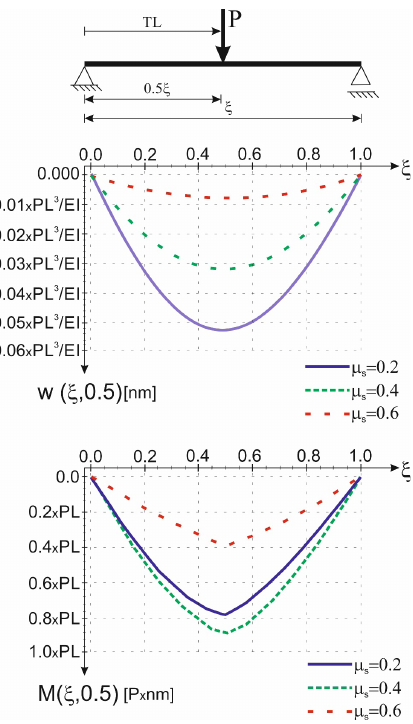
Figure 5: Strain gradient model. Displacement and bending moment of the beam for 5.0 = T .05.0 = g η 001.